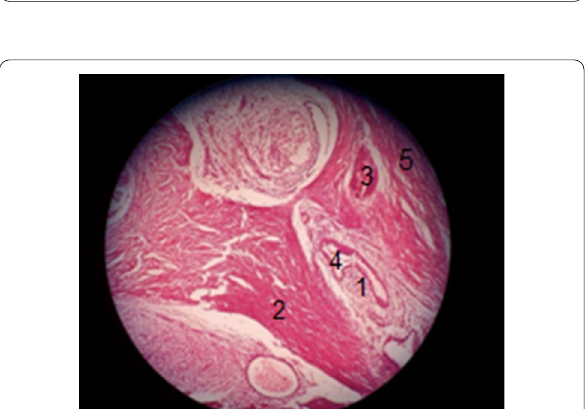
Fig. 6 Microscopic view of the specimen (Regions 1 and 2 show the endometrial nests and fibroadipose tissue of the renal capsule, respectively)